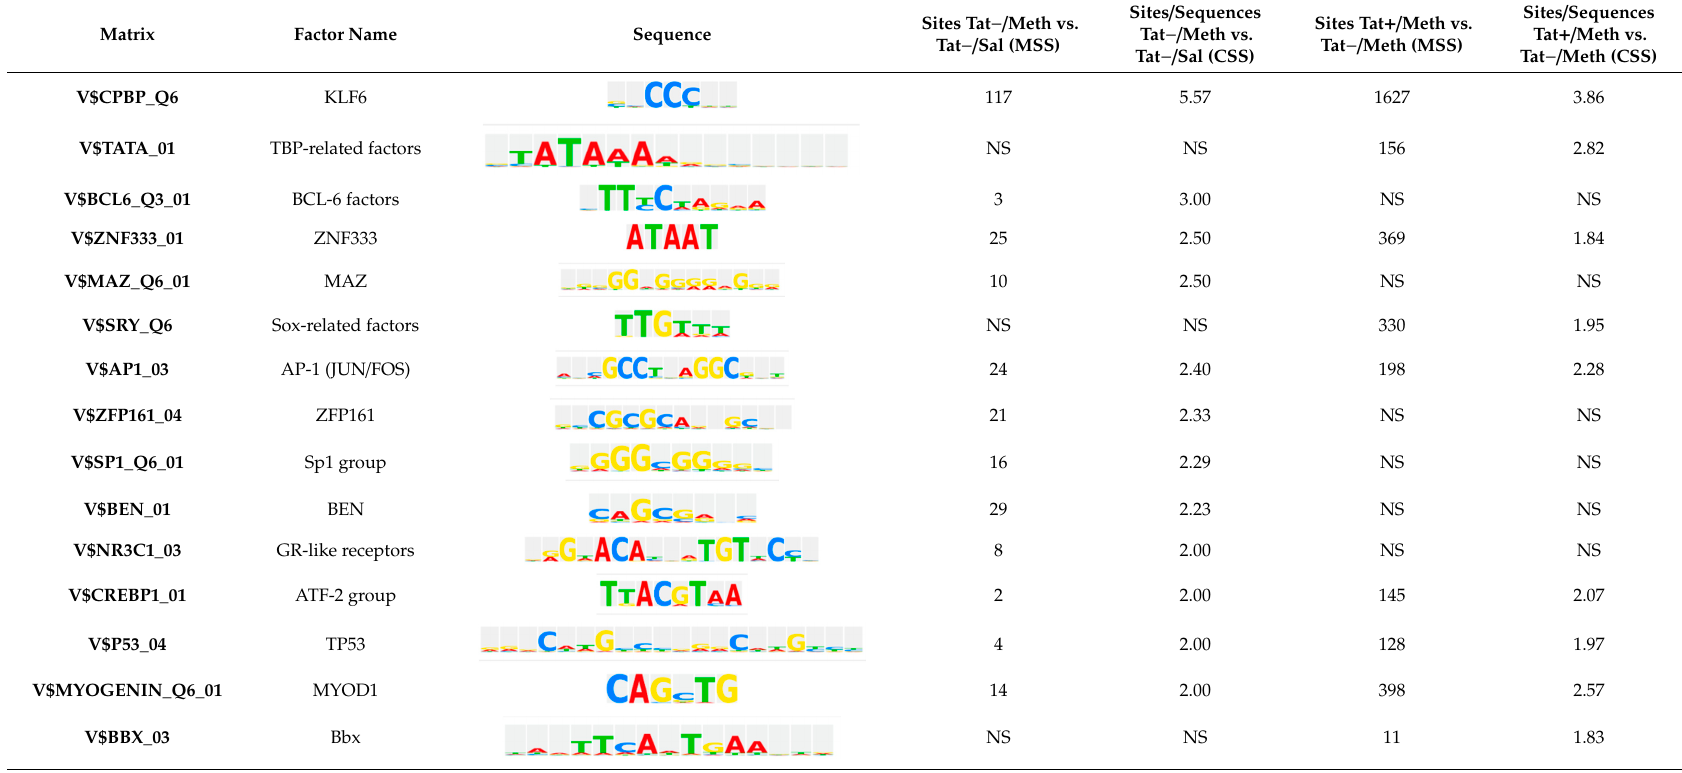
Table 5. Transcription factor motifs site / sequence matrix identified in the proximal promoter region of genes upregulated by Meth alone, from the comparison between Tat − / Meth versus Tat − / Sal brains, and of genes upregulated by Tat in the context of Meth, from the comparison between Tat +/ Meth versus Tat − / Meth brains. NS = not